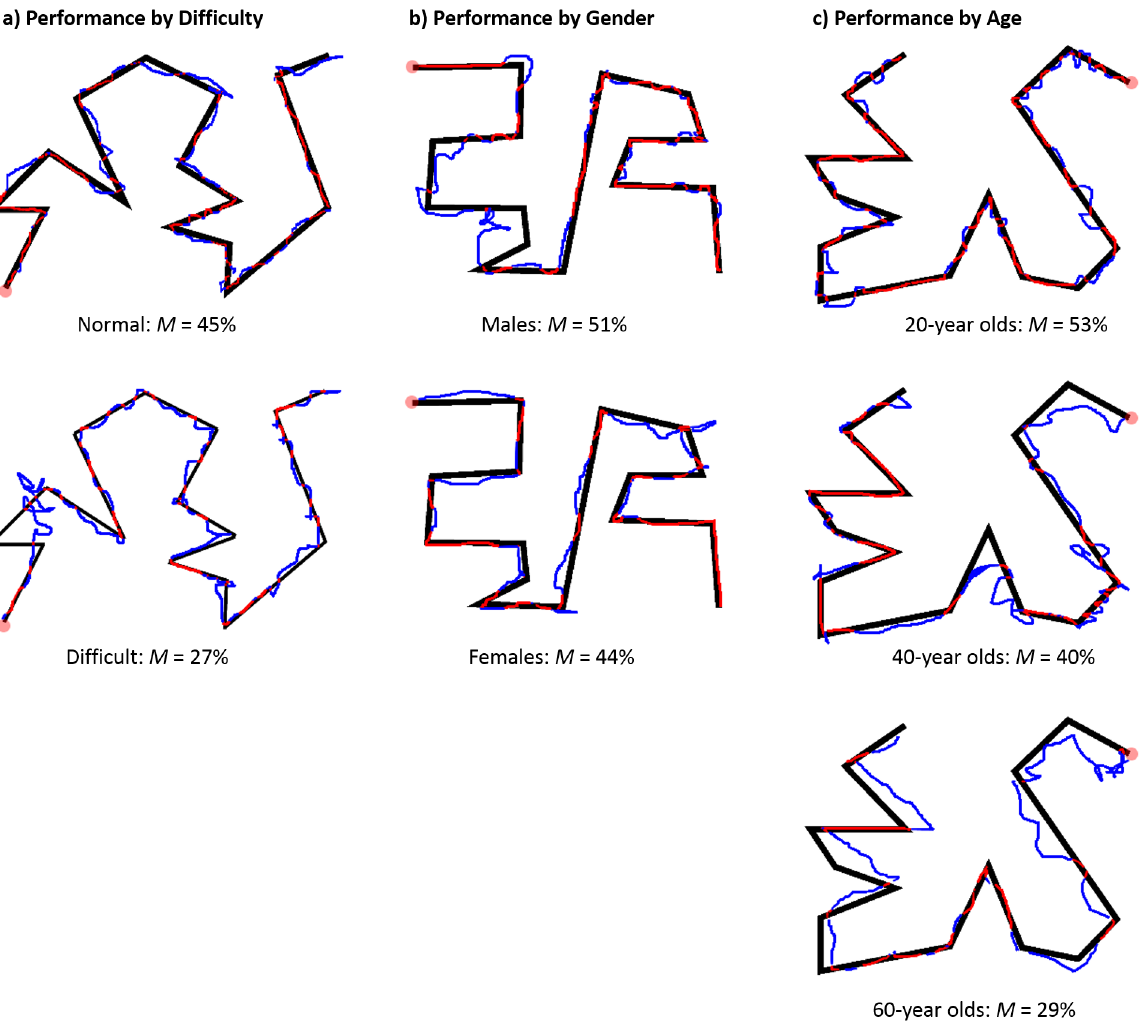
Fig 3. Examples of mirror tracing performance for different difficulties, genders, and ages. Each tracing is from an actual participant in Experiment 4. Tracings were selected to have a score at the mean for the category. A) Task difficulty: reducing the line thickness of the tracing form substantially increased difficulty and reduced scores. B) Gender: Men tended to perform slightly better than women on this task. C) Age: Younger participants were somewhat better at this task than older